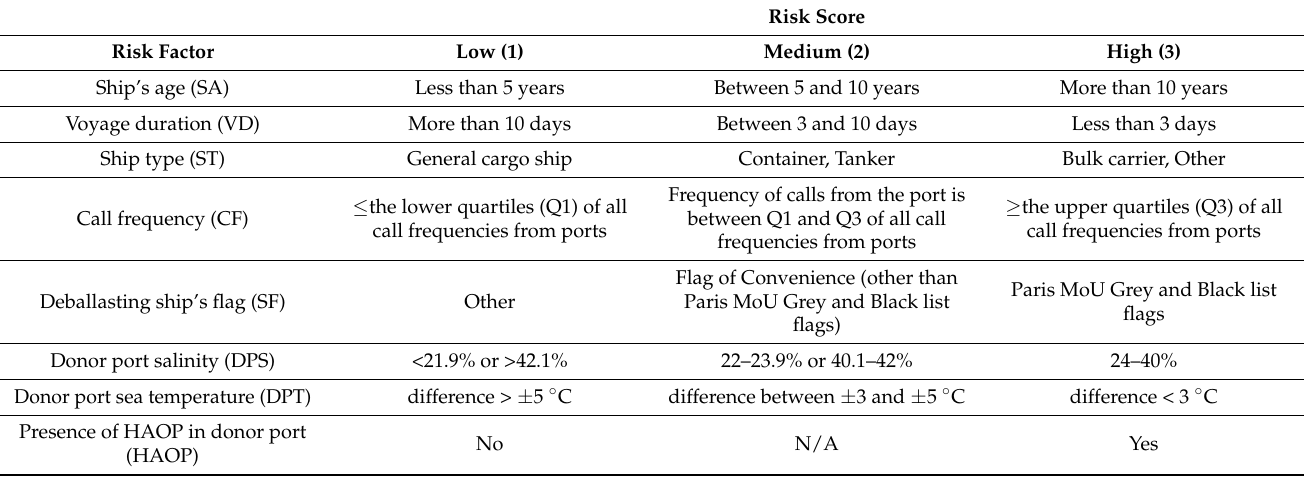
Table 1. BWRA factors scoring for the Port of